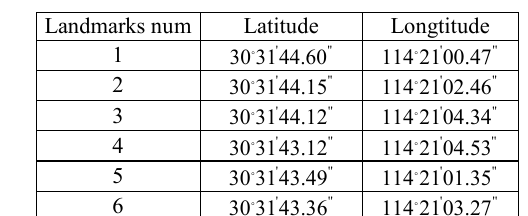
Figure 5 . Test Scenario, including (a) Mall Map & Landmarks (b) Mall Environment The coordinates of each landmark are shown in Table 3. Table 3 . The Coordinates of Each